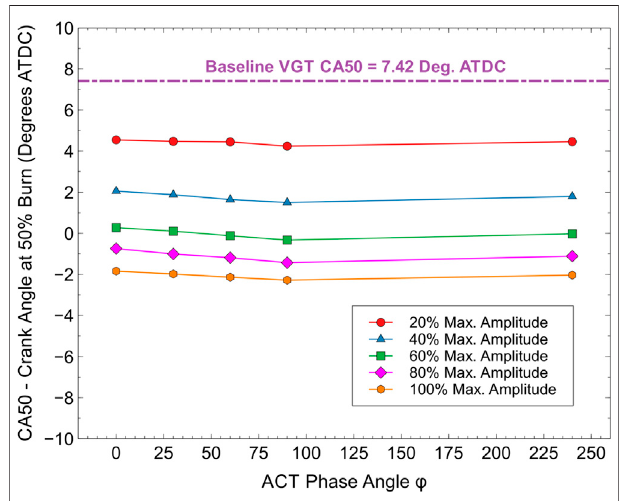
FIGURE 9 | CA50 variation with amplitude ratio and phase angle.